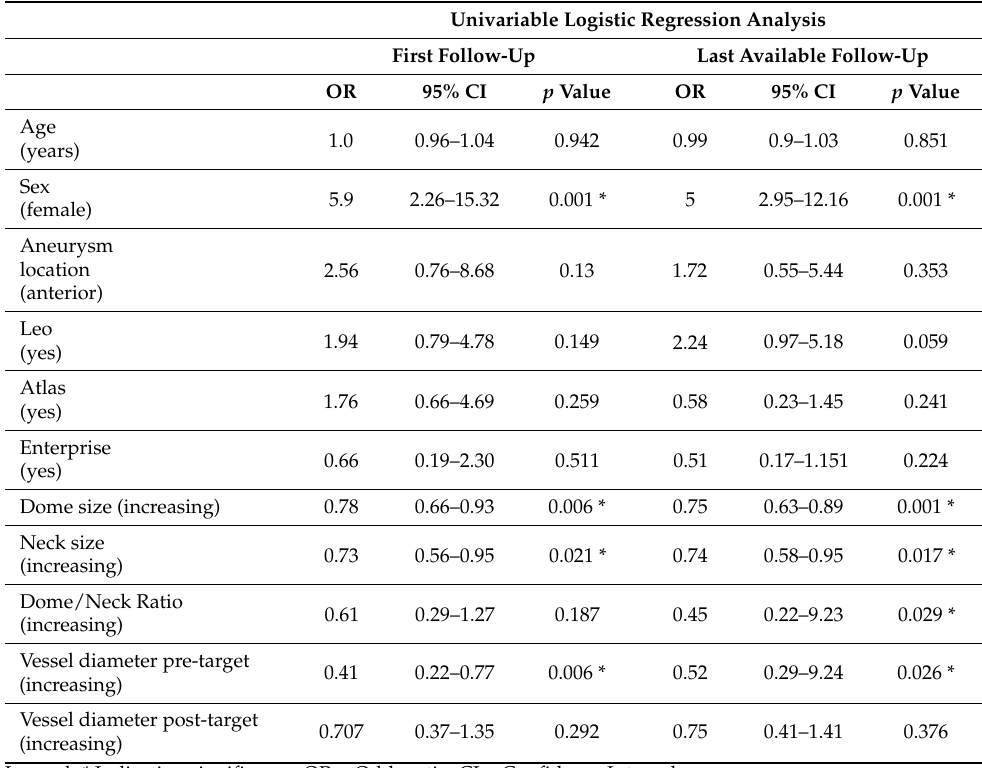
Table 3. Univariable logistic regression analysis for factors associated with complete aneurysm obliteration (Raymond–Roy occlusion class I) at first and last available follow-up.